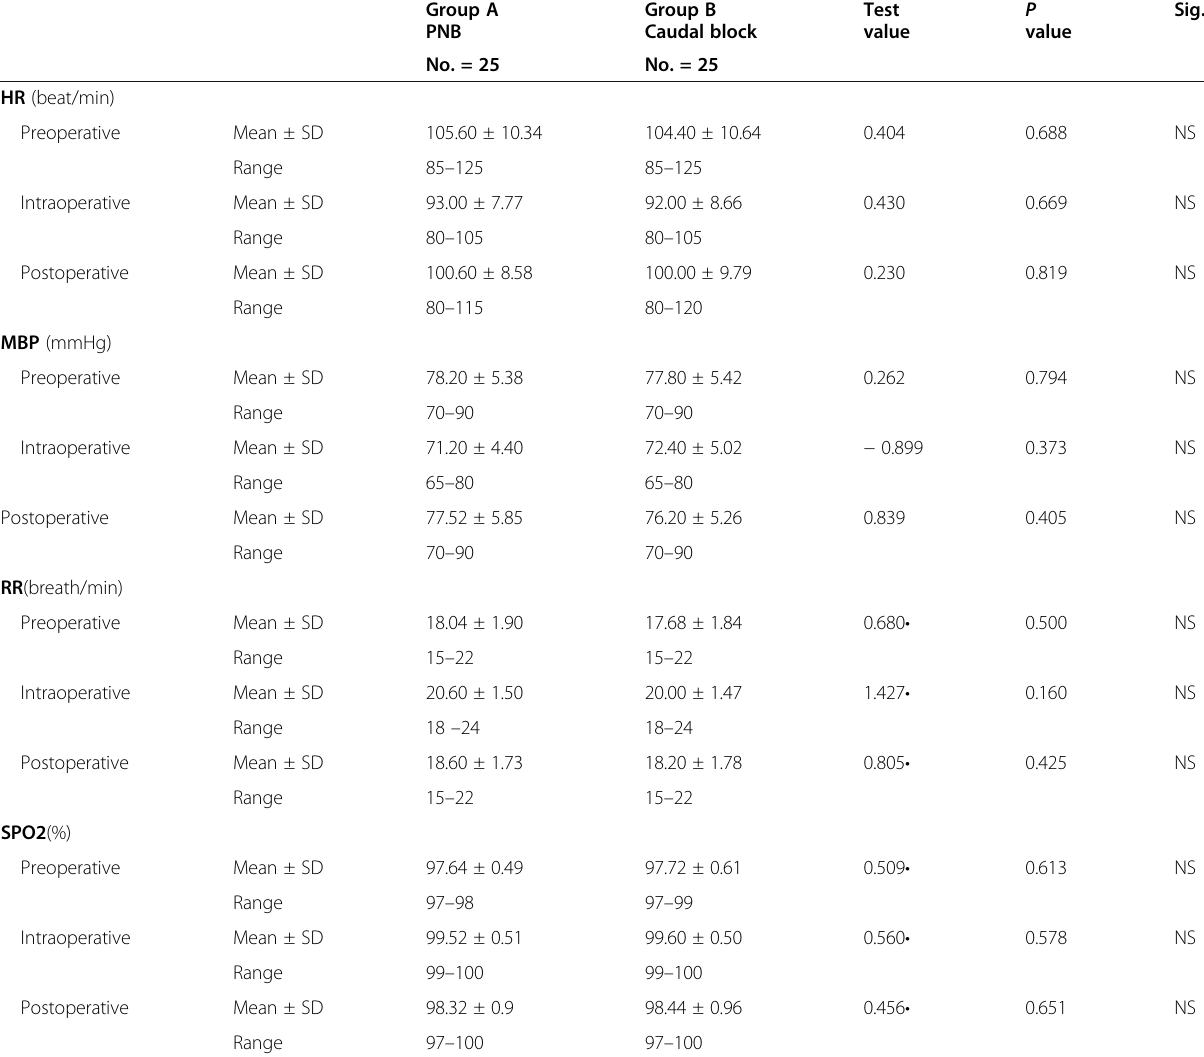
Table 4 Perioperative comparison between the studied groups regarding heart rate, mean arterial blood pressure, respiratory rate, and oxygen saturation